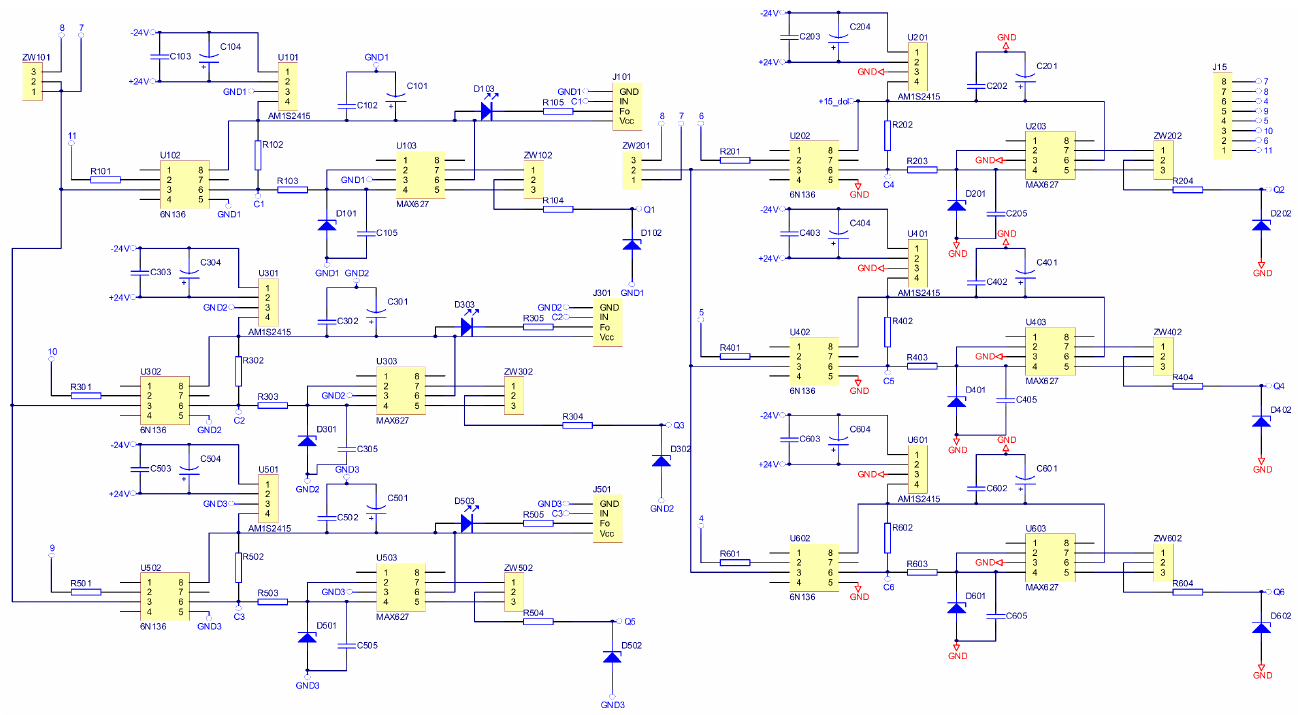
Figure 17. Schematic diagram of the construction of a rectifier bridge.